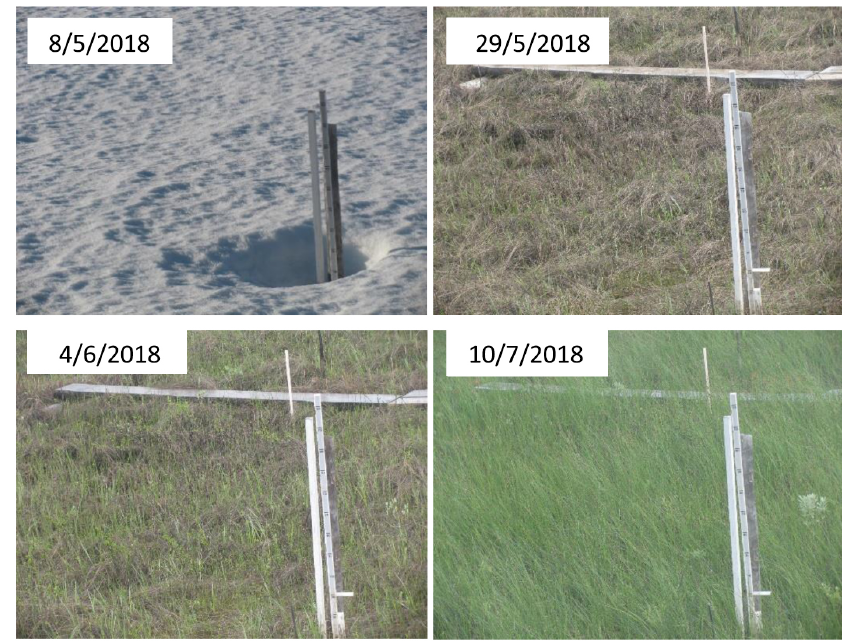
Figure 6. Variation in the vegetation cover at Lompolojänkkä fen over the growing season in 2018.